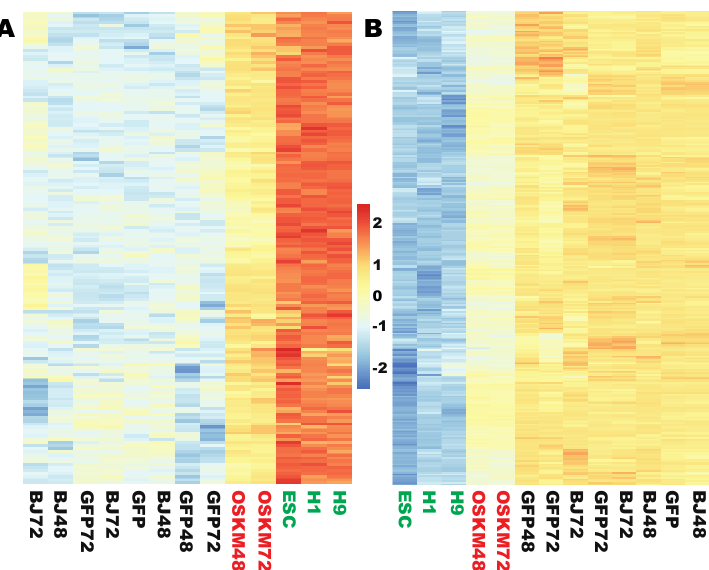
Figure 6. Two sets of genes were significantly but insufficiently reprogrammed by OSKM at the early stages. (A ) A heat map showing that 152 ESC-enriched genes were significantly upregulated but insufficiently upreprogrammed by OSKM. (B ) A heat map showing that 286 fibroblast-enriched genes were significantly downregulated but insufficiently downreprogrammed by OSKM. Figure sample labels are the same as in Figure 1.